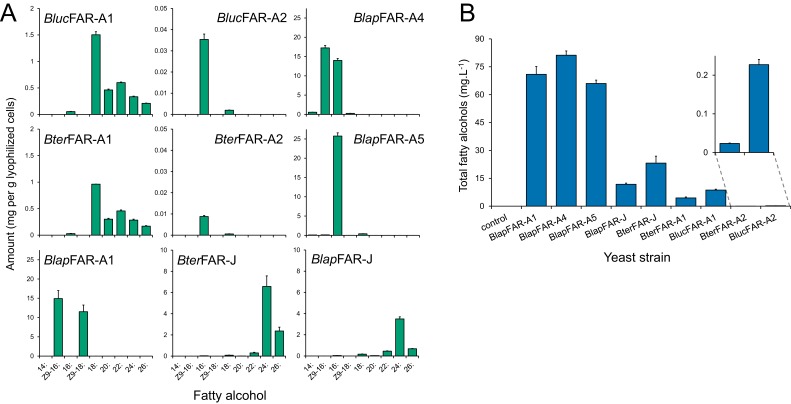
The quantitative aspects of fatty alcohol production in yeasts expressing bumble bee FARs.(A) Quantities of individual fatty alcohols produced in yeast relative to the lyophilized cell biomass. Note the differences in respective y-axis scales. (B) Quantities of total fatty alcohols produced by FAR-expressing strains relative to the culture volume.